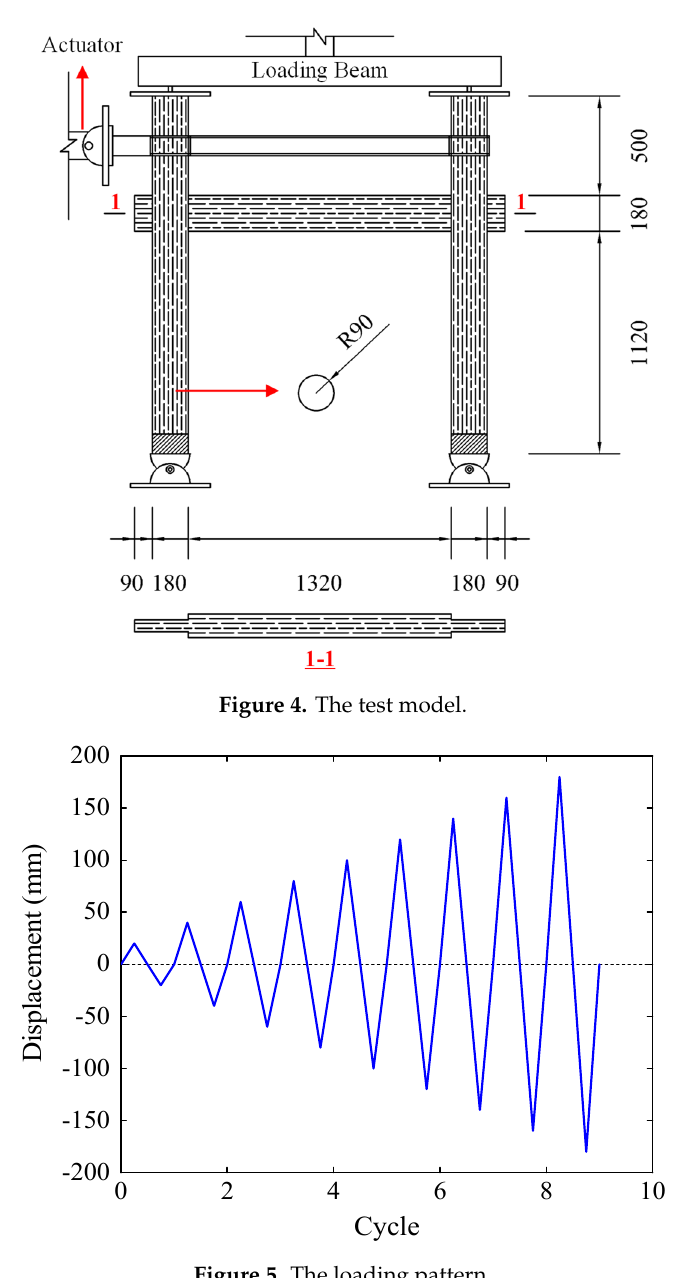
Figure 5. The loading pattern.